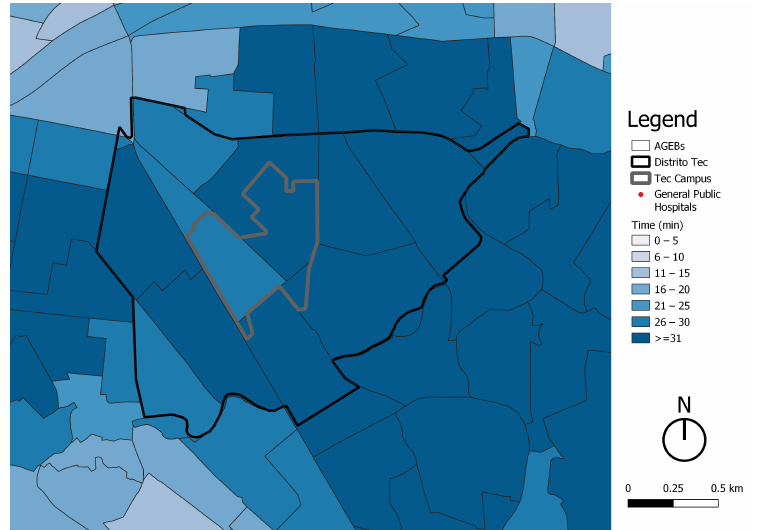
Figure 21. Distrito Tec average travel time to the closest public general hospital by